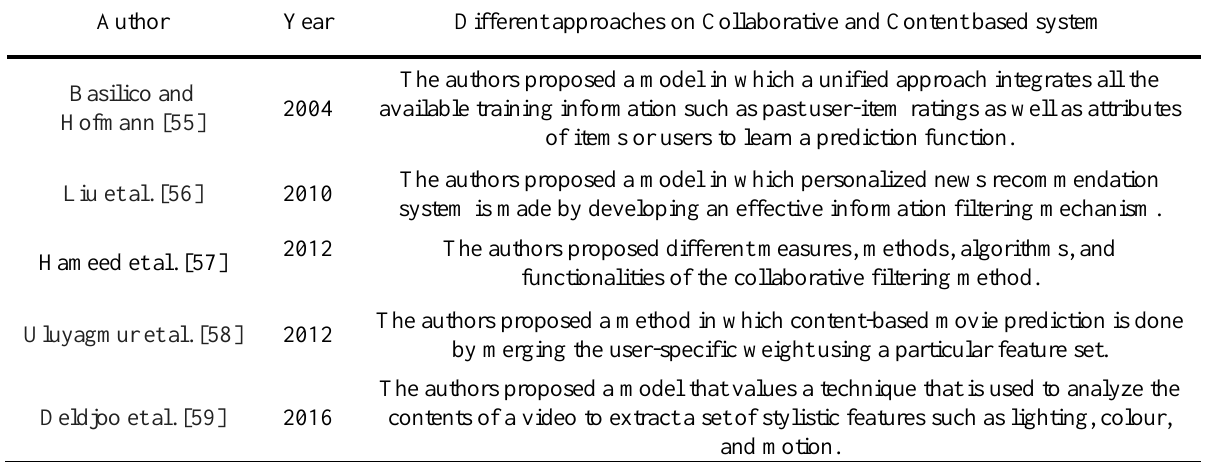
Table 4 discusses the different contributions on filtering